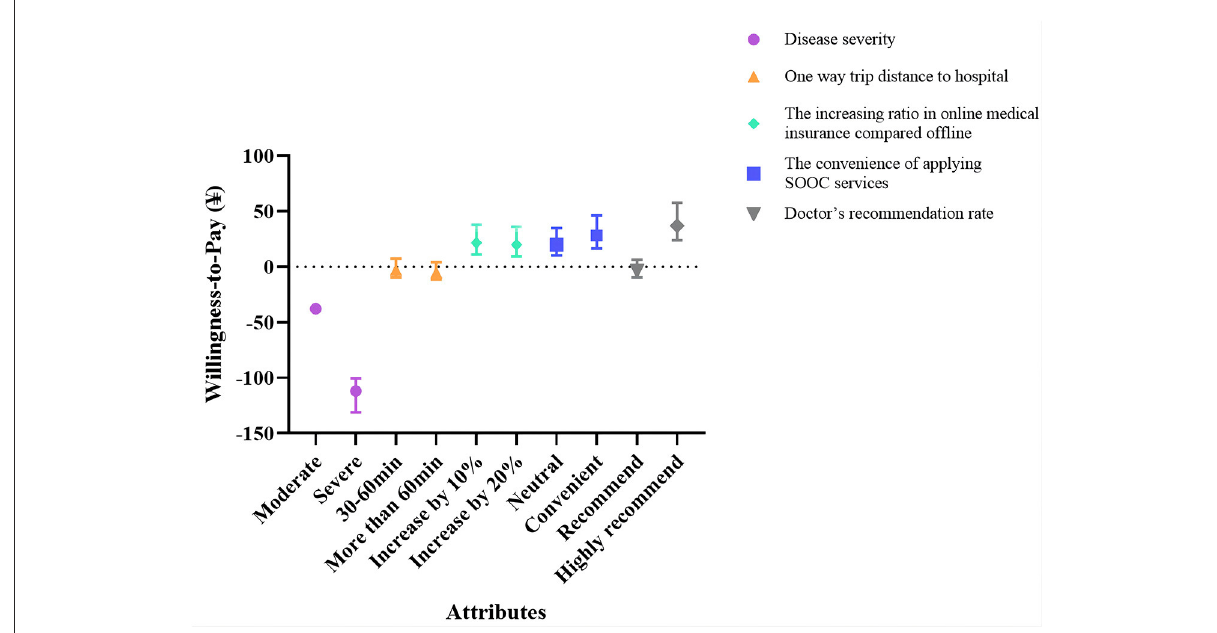
FIGURE2 WTP estimates for SOOC